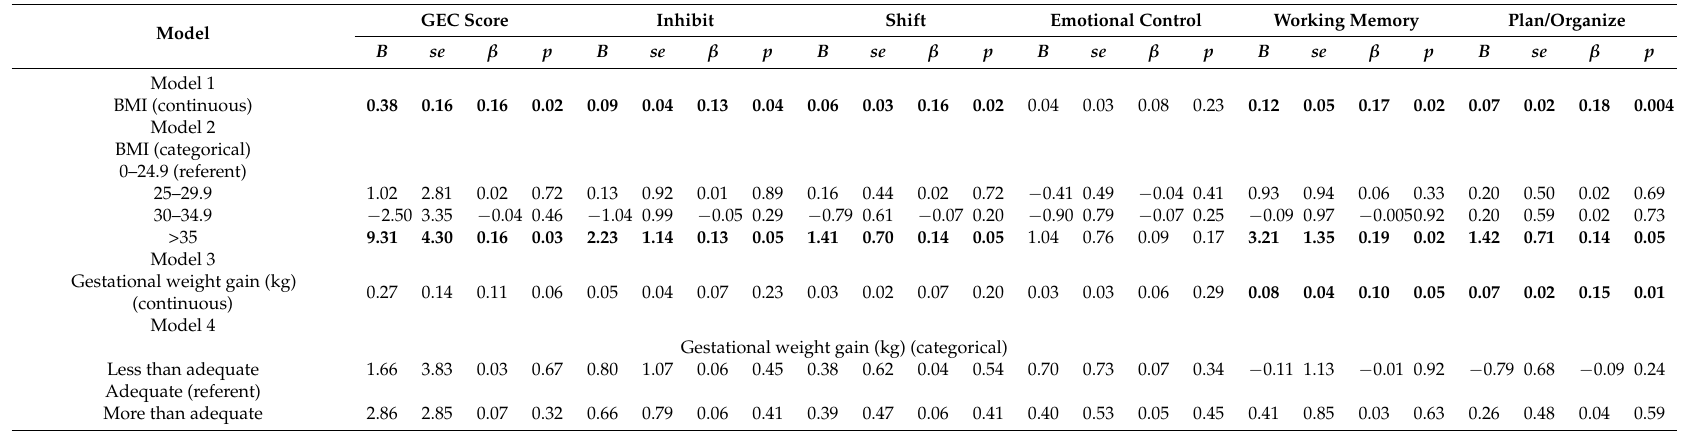
Table 3. Association between pre-pregnancy BMI, gestational weight gain, and childhood BRIEF GEC score ( n = 331). Shift Emotional Control Working Memory